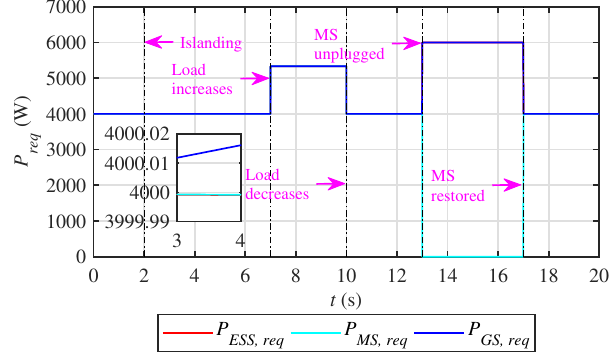
Figure 7. Real powers externally requested from DG